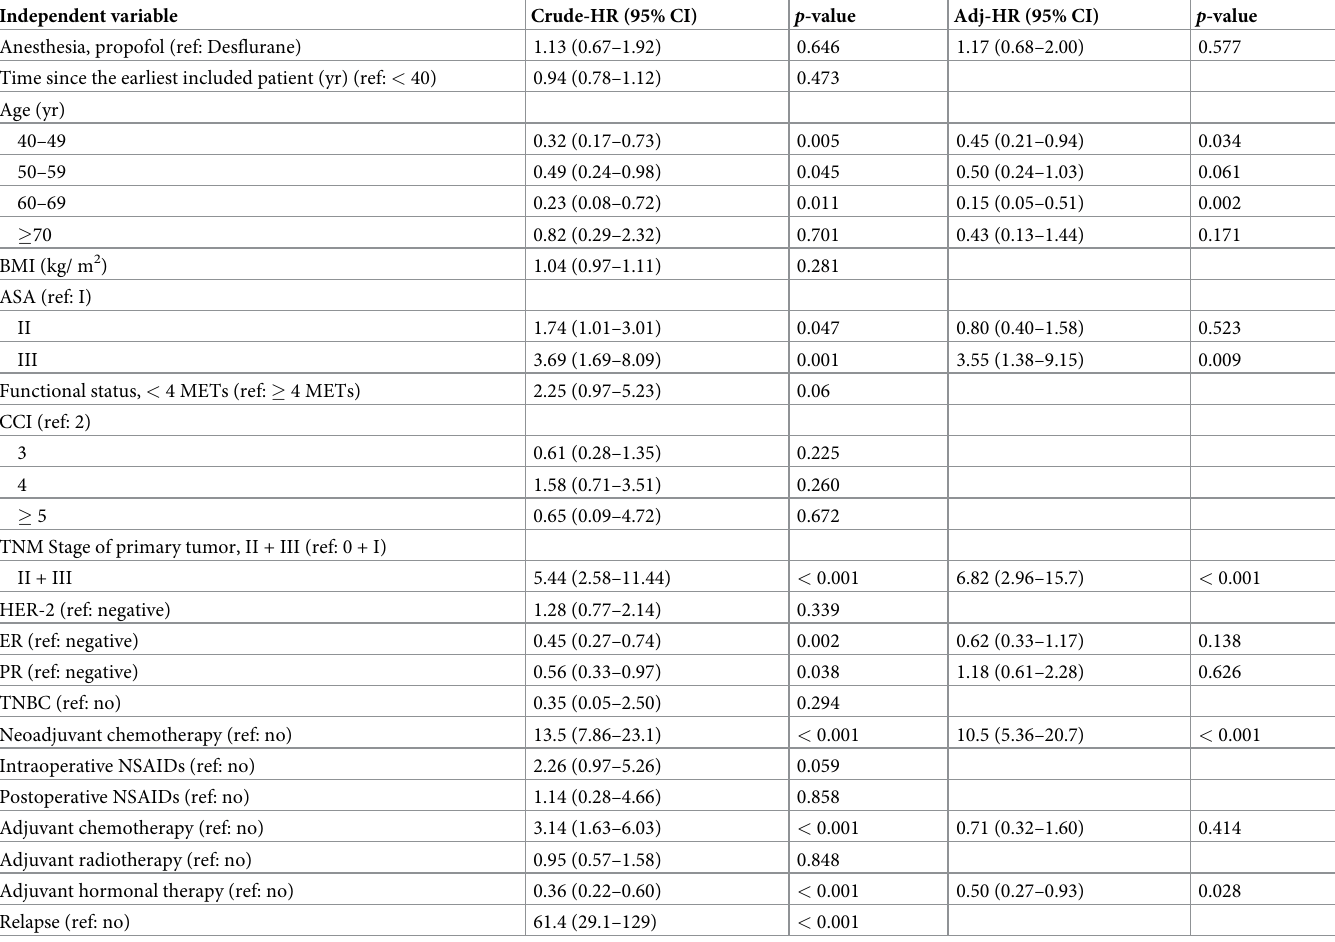
Table 2. Cox regression proportional hazard survival: Univariable and multivariable models for overall patients (n = 976). Independent variable Crude-HR (95%